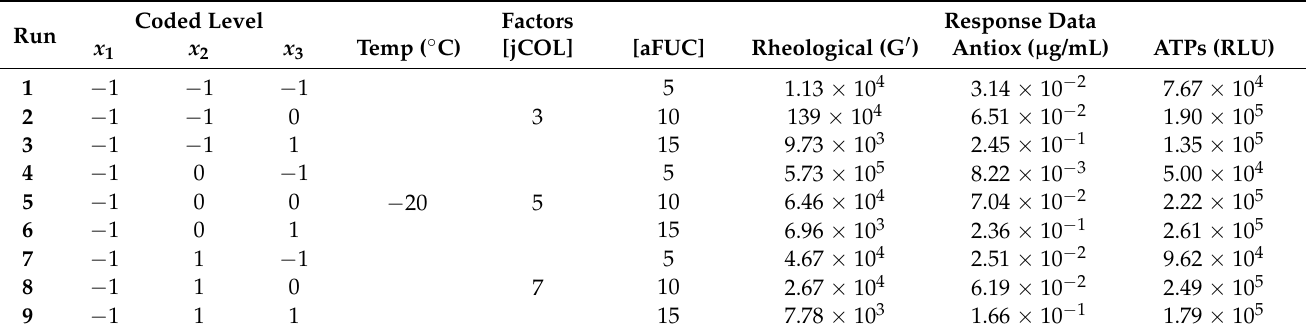
Table 3. Experimental runs for Box–Behnken with 3 3 factorial design. Coded levels and the variable factors are shown. For response data, the information of rheology and antioxidant activity showing the average of three independent experiments and the information data of ATPs is relative to the average of three independent experiments of timepoint day